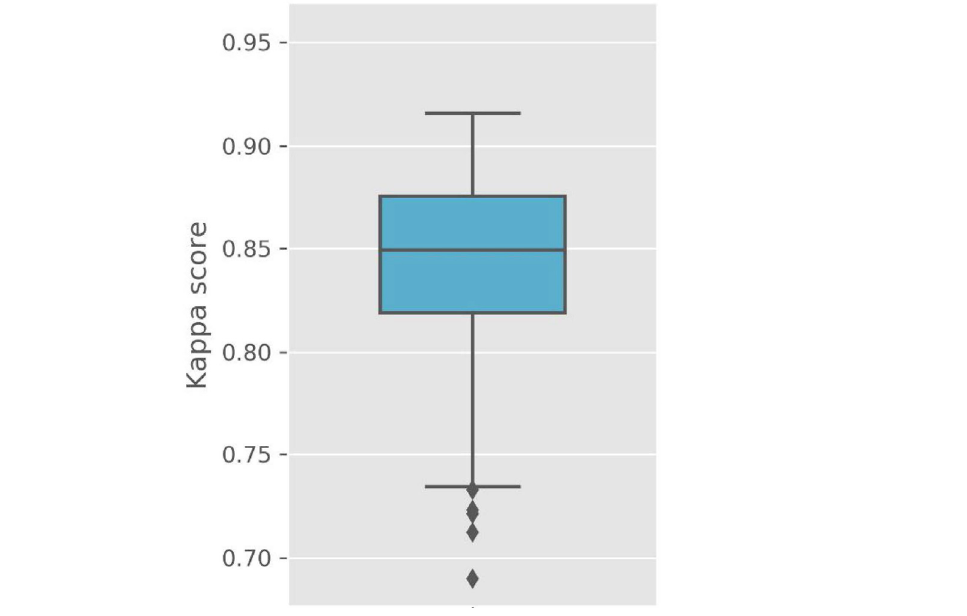
Figure 2. Cohen’s kappa value. Kappa value: median of 0.85, average of 0.84, standard deviation of 0.05, maximum value of 0.92, and minimum value of 0.69. Table 2. Bootstrapped point-estimate of median percent agreement (%) with a 95% bootstrap confi- dence interval.